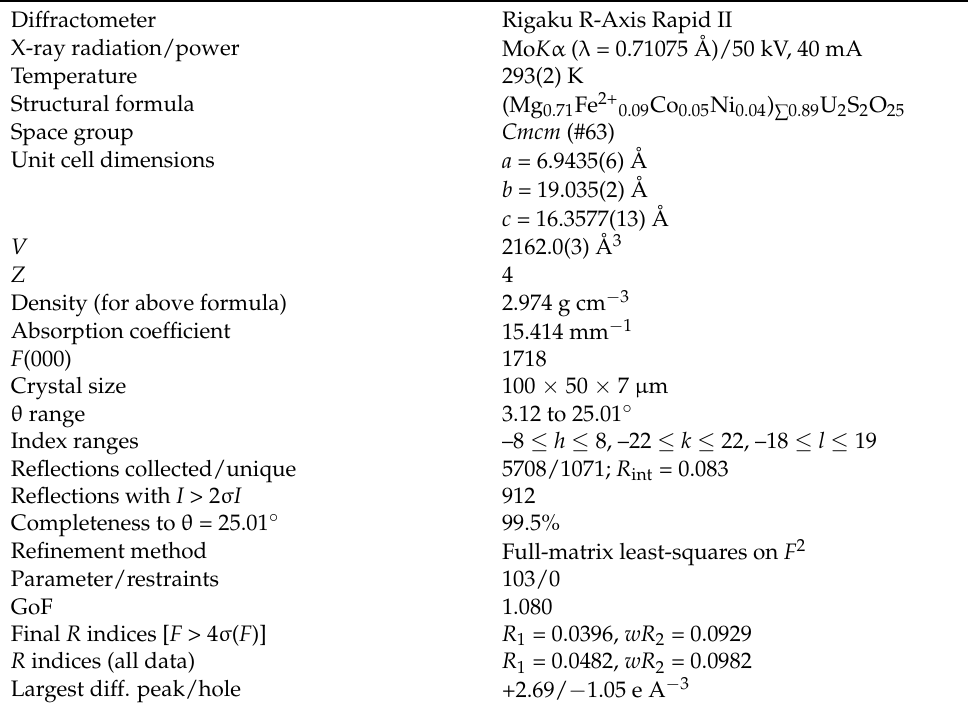
Figure 4. The coordination of the split Mg site in the structure of chenowethite. Table 3. Data collection and structure refinement details for